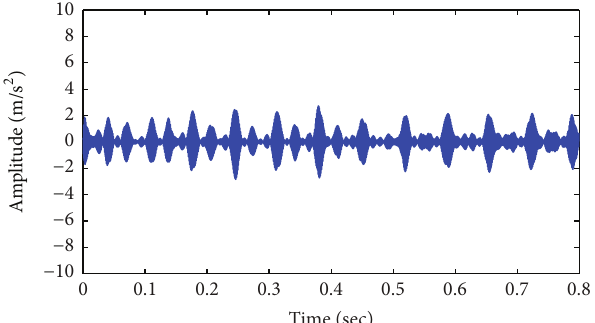
Figure 17: Reconstructed signal over the band 900–1200 Hz.